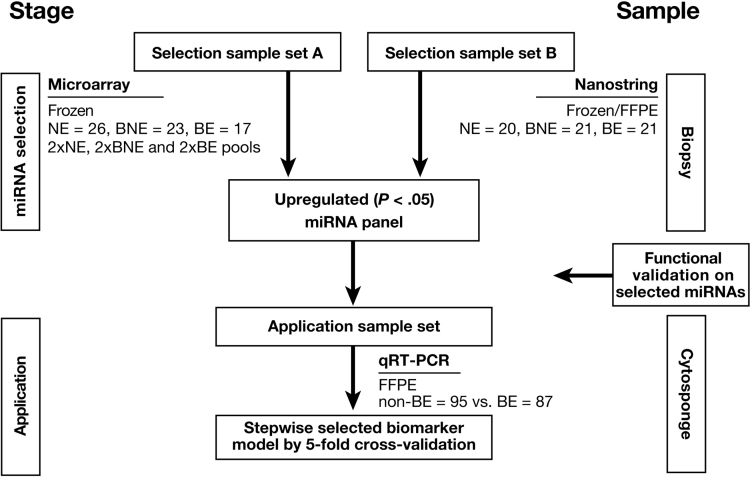
Schematic illustration of the study design and strategy. Summary of methods divided into 2 stages of Selection (A and B) and application using both biopsy-derived and Cytosponge-derived samples.